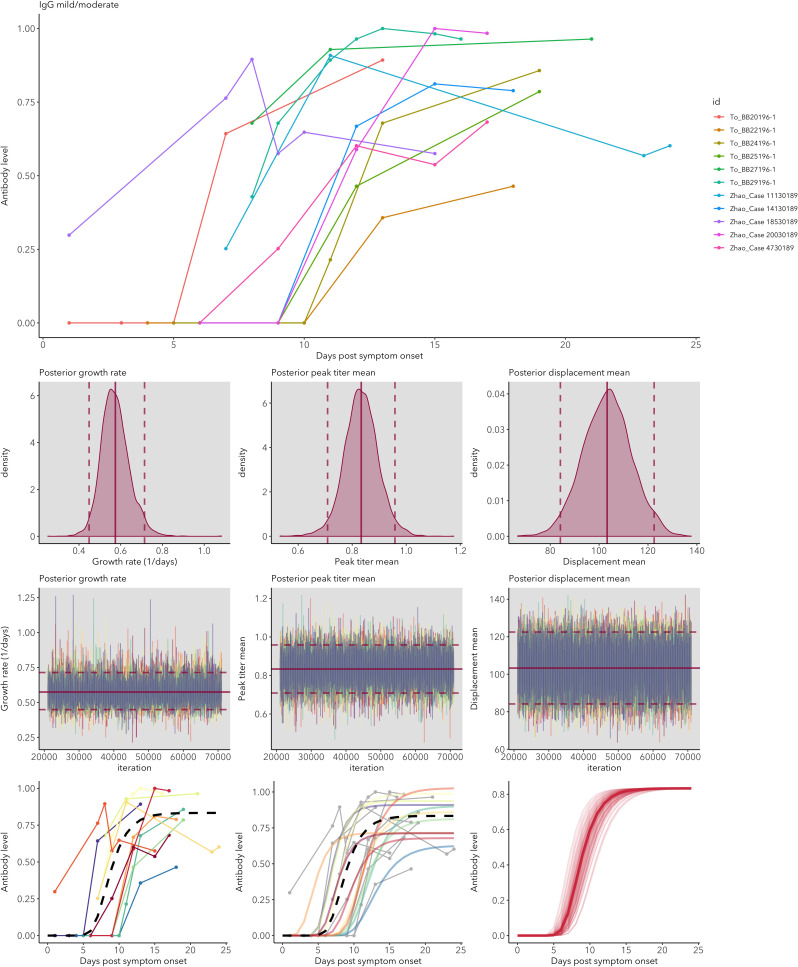
IgG mild/moderate cases fitted antibody kinetics.